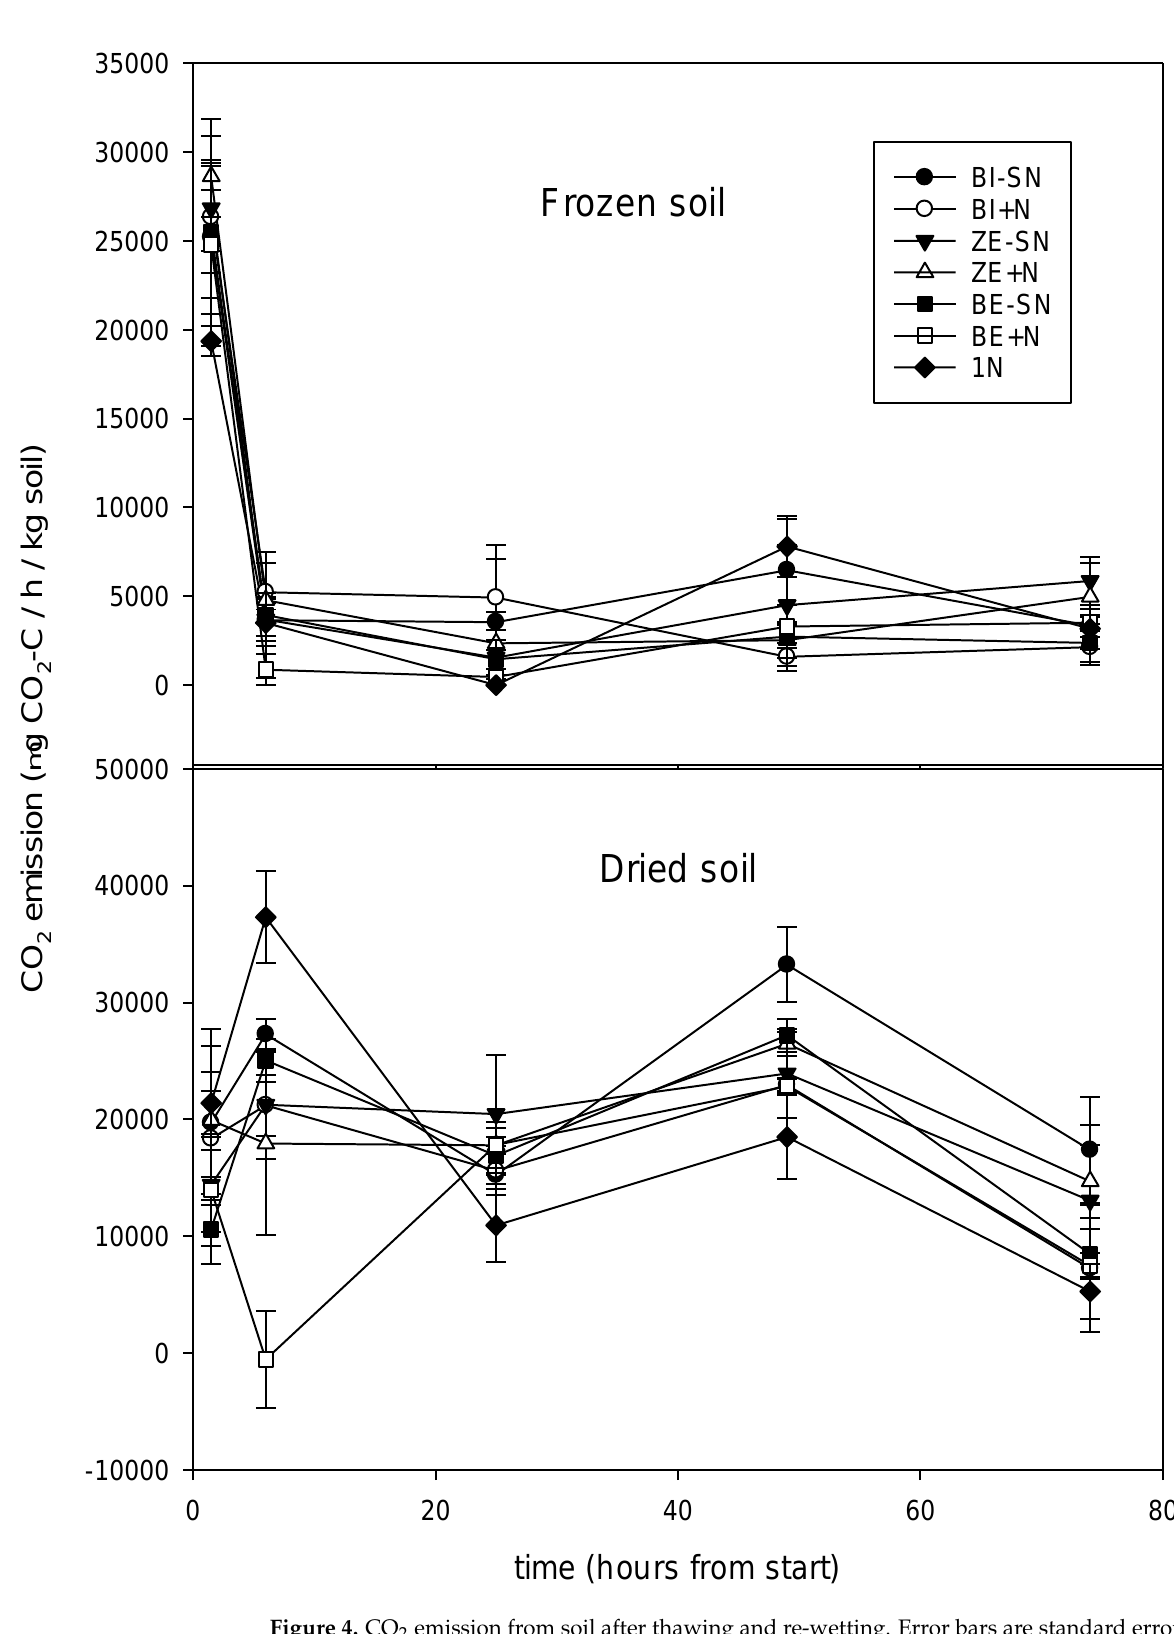
Figure 4. CO 2 emission from soil after thawing and re-wetting. Error bars are standard error (n = 3). 1N = full mineral N fertilizer, no sorbent, BI = biochar sorbent, ZE = zeolite sorbent, BE = bentonite sorbent. When sorbent and N fertilizer are both mixed into the soil separately, -SN is added. When N fertilizer is applied, sorbed with the sorbent +N is added.